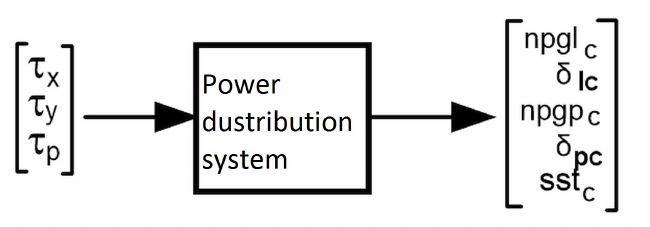
Figure 3. Distribution of the three control signals to the drive device commands: npgl c , ( npgr c )— rpm’s of the left (right) azipod propeller, δ l c , ( δ r c )—left (right) pod rotation angle, and sst c —relative force of the bow tunnel